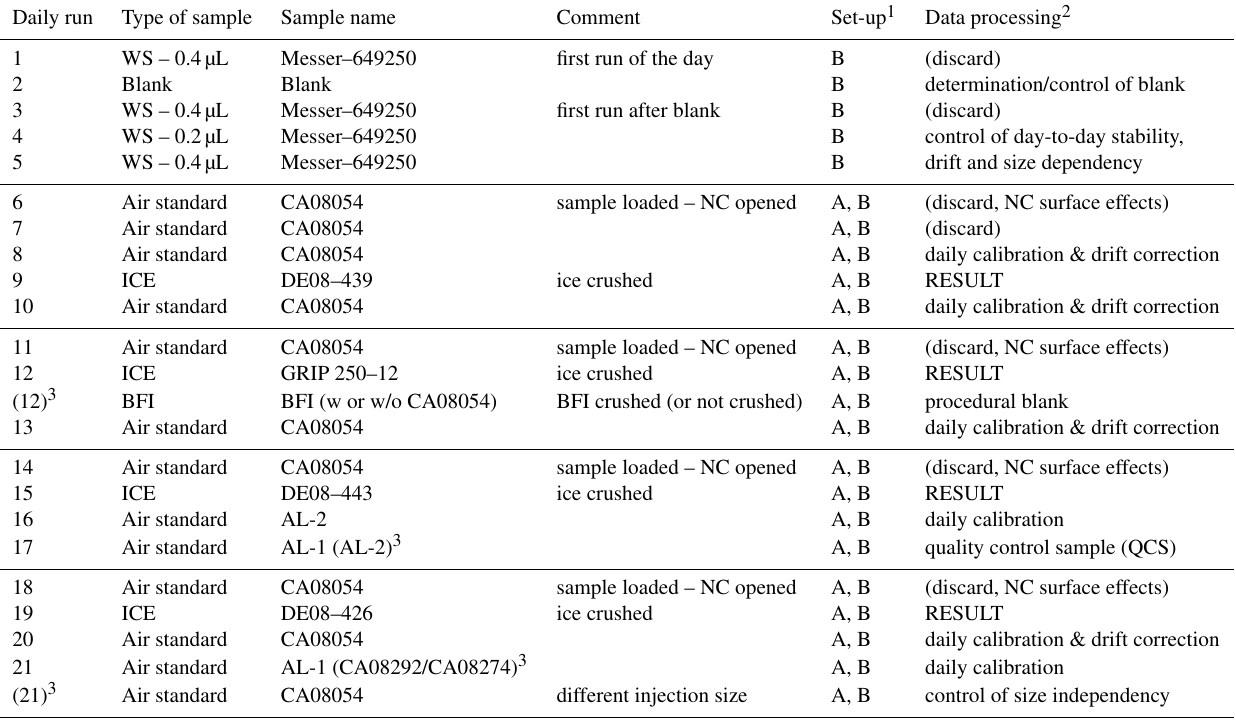
Table 3. Example of a daily measurement sequence. See Table 2 for details on standard gases (WS, air standard) and the main text for analytical procedures. BFI denotes bubble-free